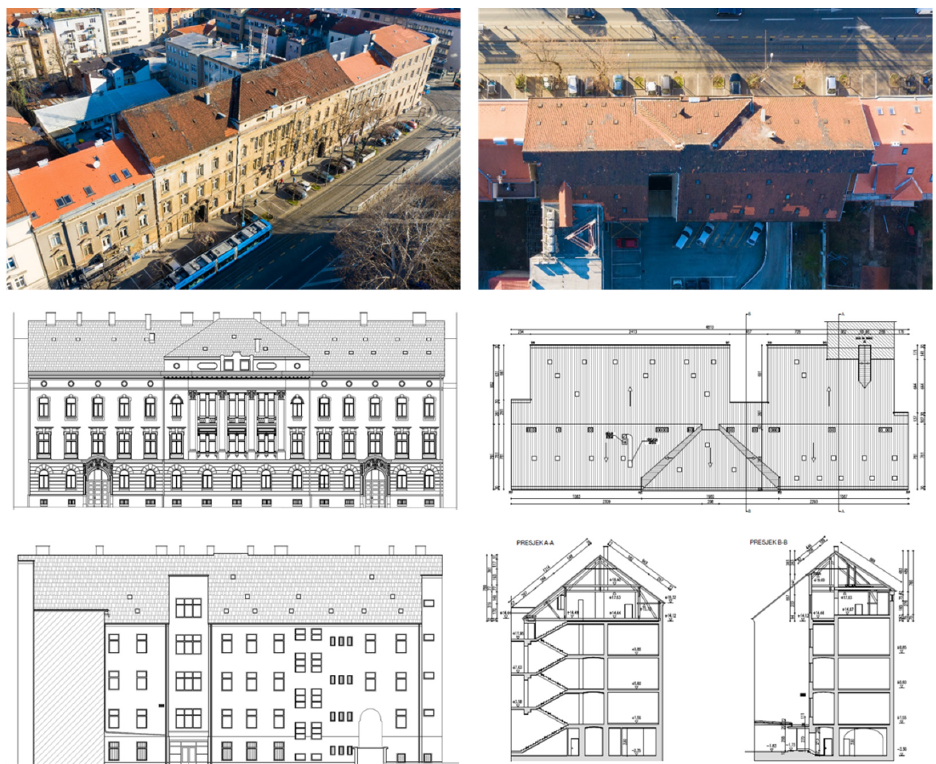
Figure 11. General view of the building.